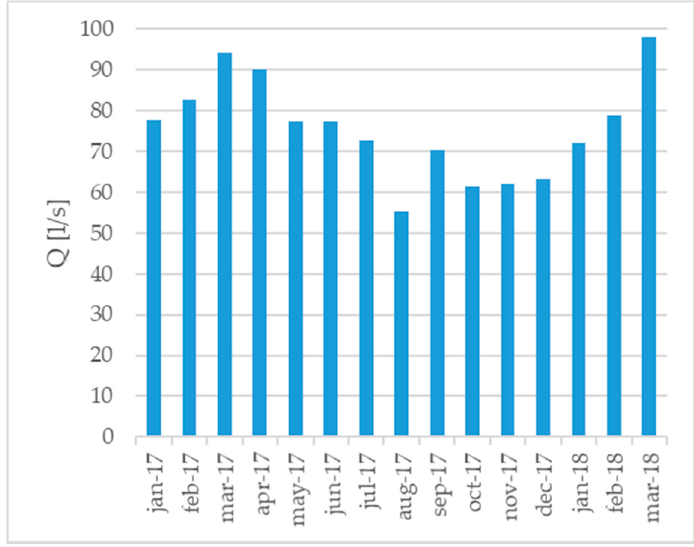
Figure 2. Monthly flow rates Q [l/s] at the “New Aqueduct”, from January 2017 to March 2018.